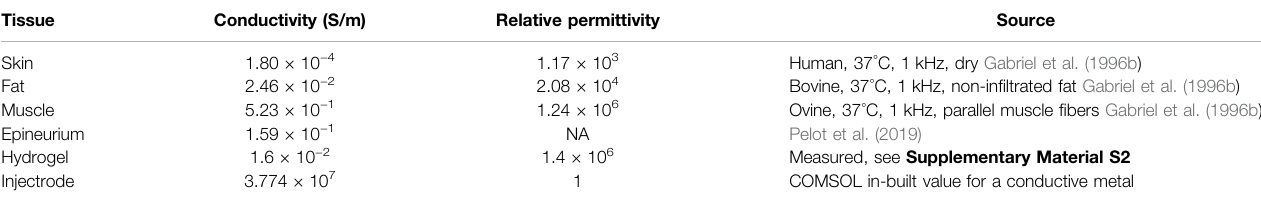
TABLE 1 | Material electrical properties used in the FEM model.